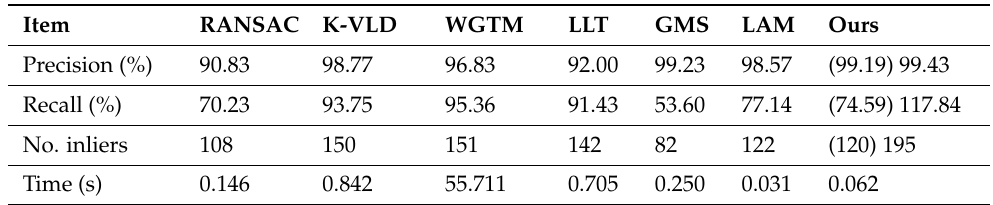
Table 2. Statistical results for the non-rigid dataset (value in the bracket indicates the statistical results without match expansion).